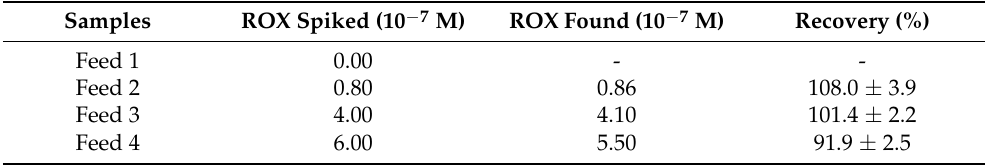
Table 2. Recovery (mean ± s; n = 3) for the determination of ROX in the feed samples.